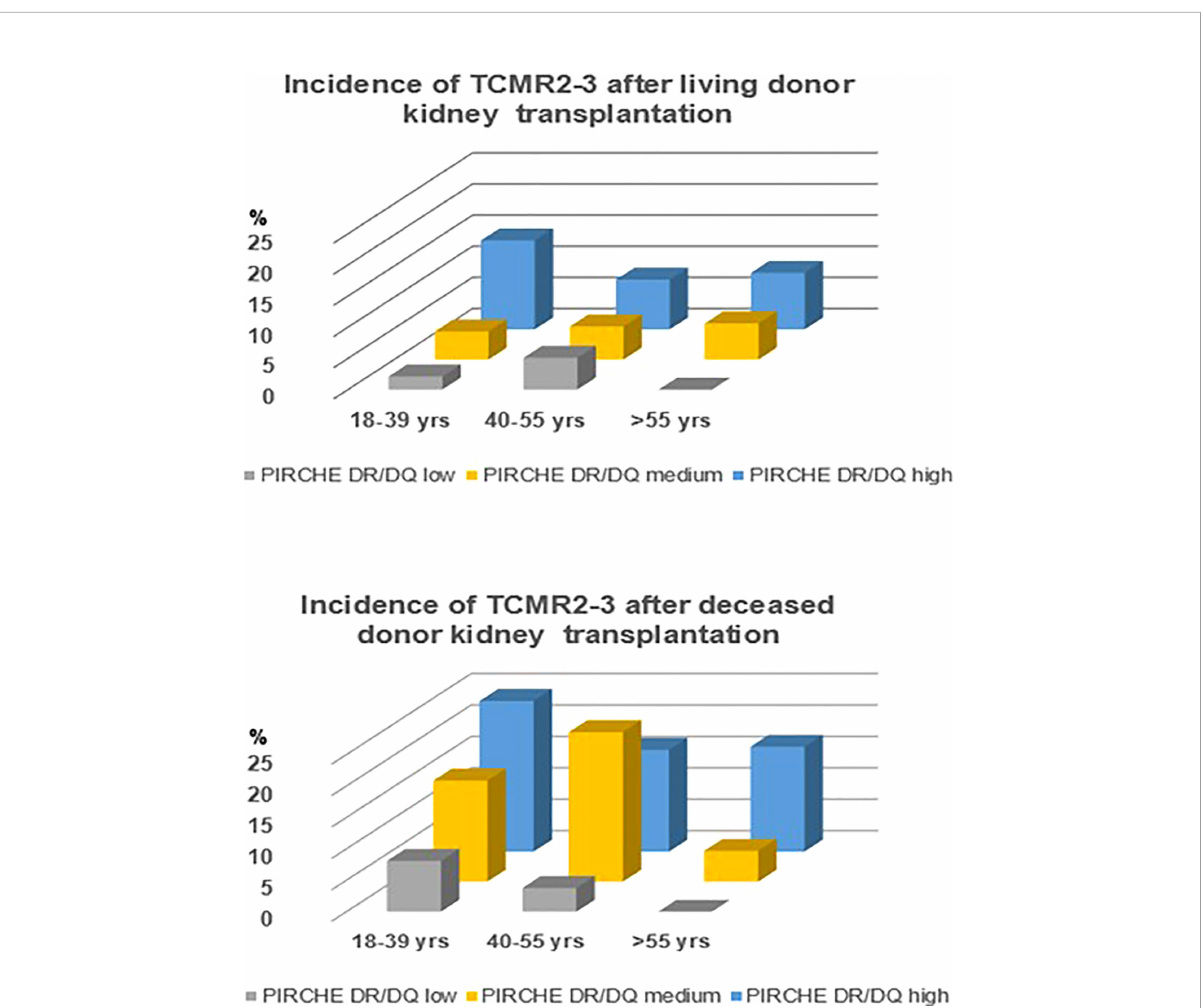
FIGURE 3 Incidence of vascular rejection (TCMR Banff grade 2-3) in relation to recipient age groups and PIRCHE-II DR/DQ tertiles for living and deceased donor kidneys.